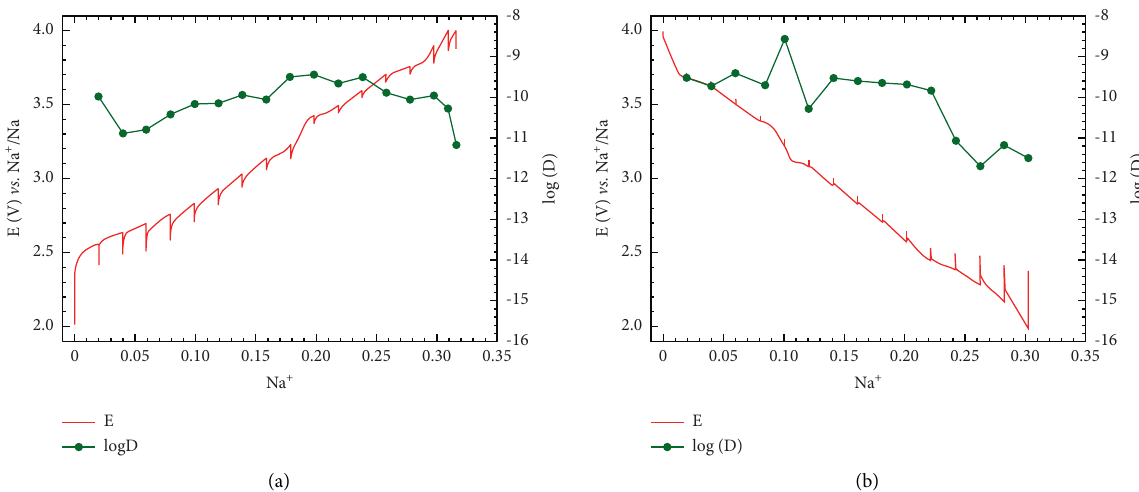
Na versus for the oxidation process (a) and the reduction process